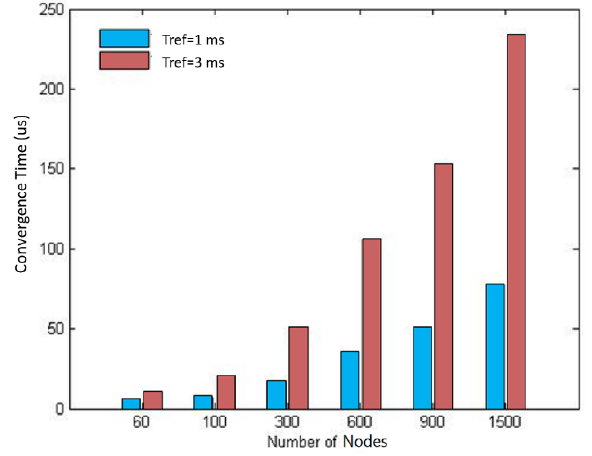
Figure 6. Convergence time of different numbers of nodes.